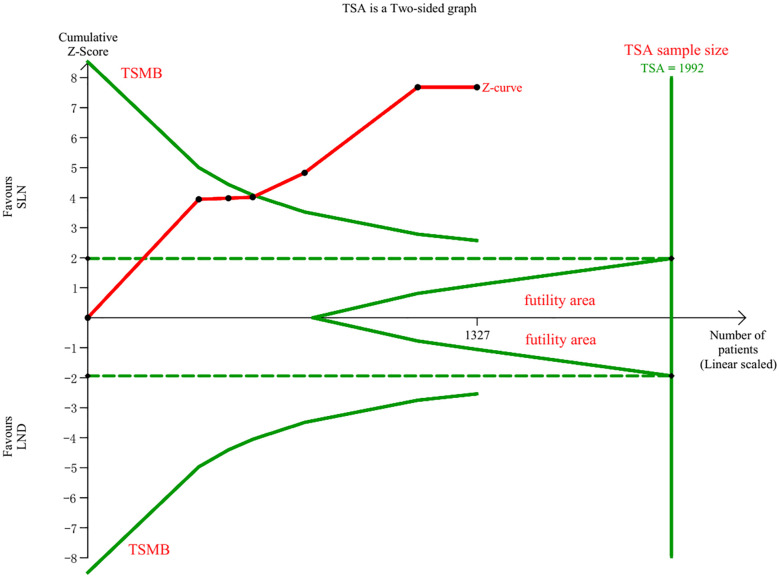
TSA of blood loss, α = 0.05, β = 0.8, two-sided test.